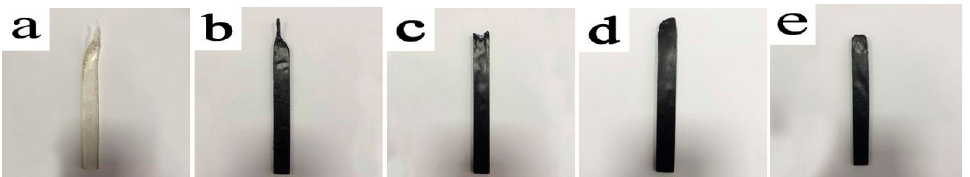
Figure 7. Sample images of PLA composites after vertical flame test: PLA ( a ); mBC/PLA95 ( b ); mBC/PLA90 ( c ); mBC/PLA85 ( d ); mBC/PLA80 ( e